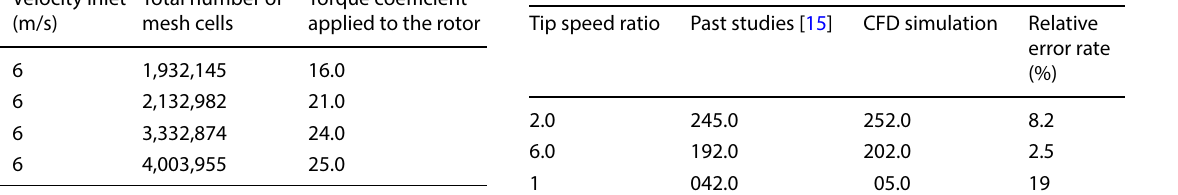
Table 3 Comparison of production torque coefficient between sim- ulation results and wind tunnel at 8 m/s